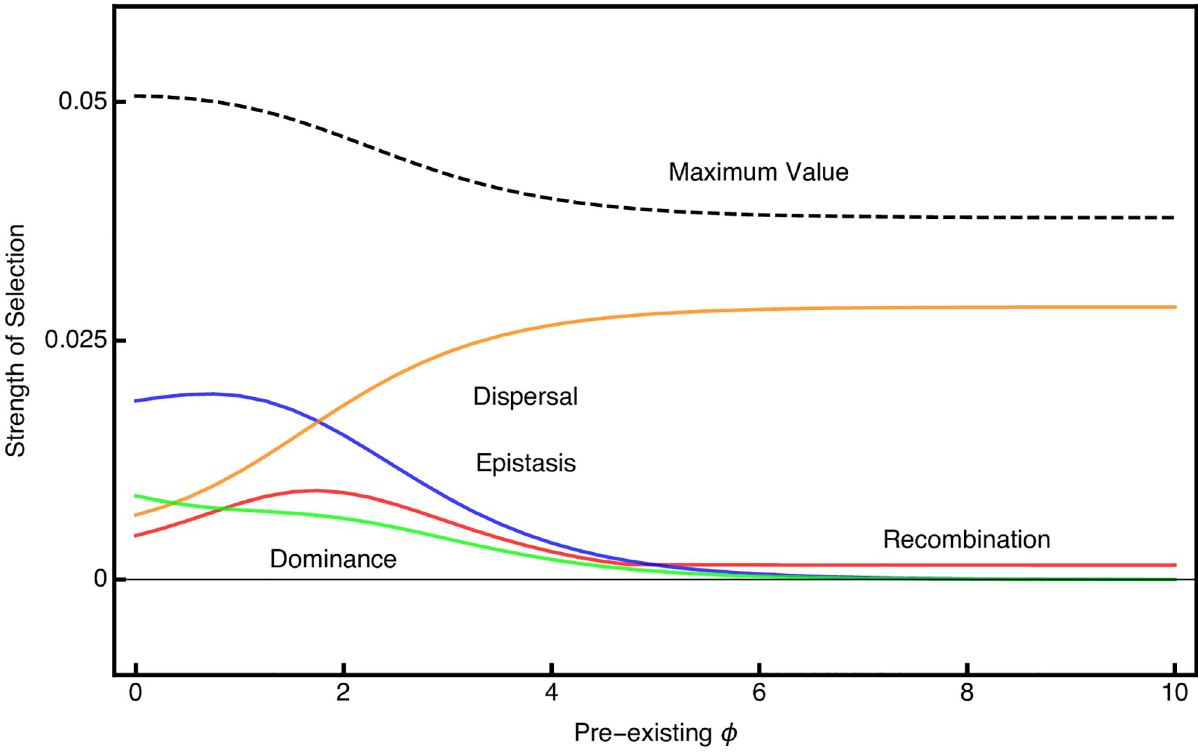
Fig 5. Strength of selection on different modifiers depends on the level of pre-existing epistasis. Parameter values for the ancestral population are k = 5, S = 0.1, M = 0.05, R = 0.5; θ = 0. ϕ is varied between 0 and 10. Strength of selection is shown for modifiers with extreme effects.